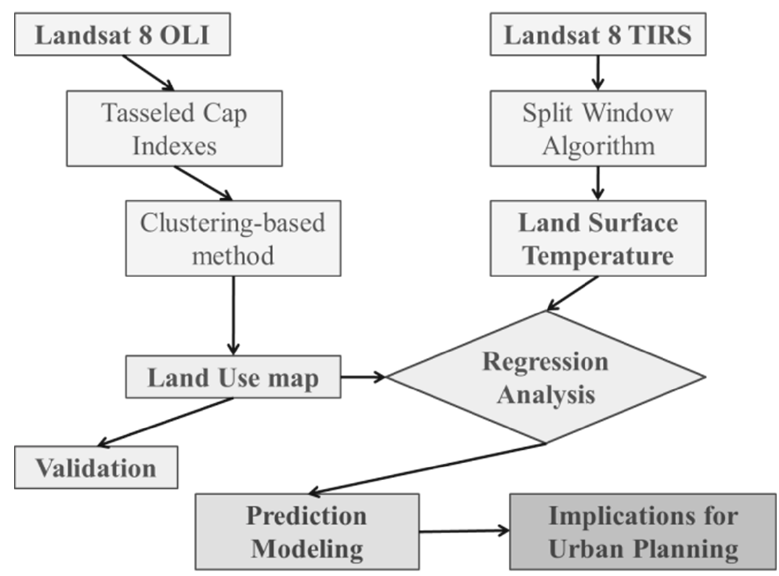
Figure 3. Outline of the research flowchart.